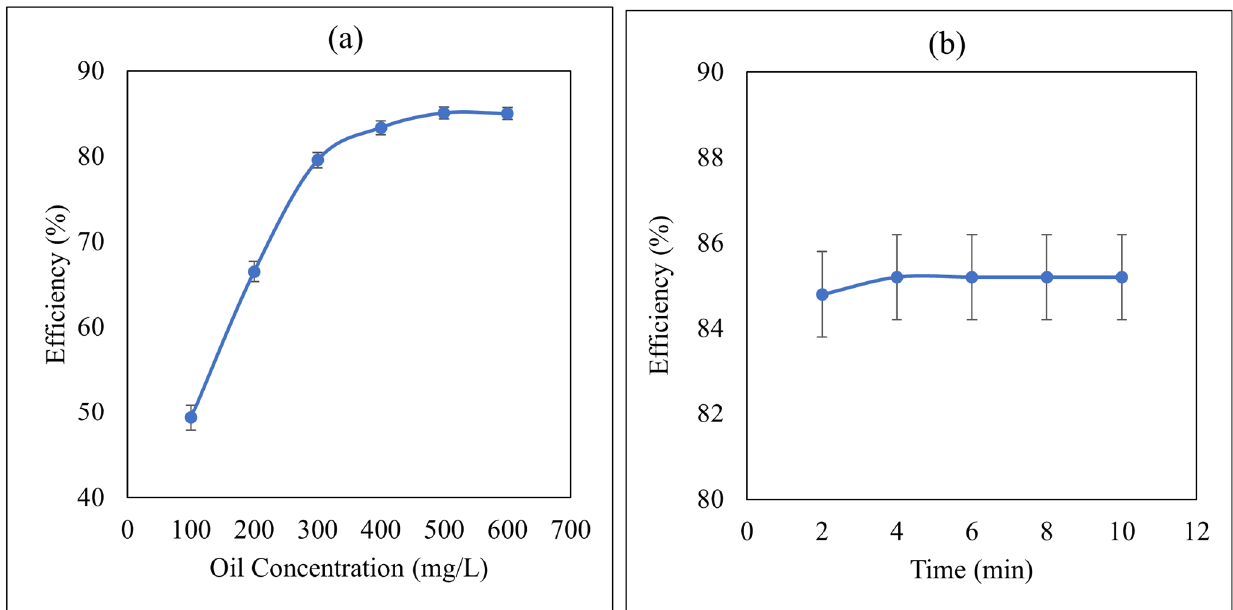
Figure 2. ( a ) Effect of the initial concentration of oil in PW on its removal efficiency by IL4 at Phase ratio (IL:PW) = 1:5, contact time = 5 min, and temperature = 25 °C, with σ = ±5.16 × 10 − 1 %, ( b ) Effect of the contact time on the removal efficiency of oil by IL4. Initial concentration of oil 500 mg/L, phase ratio (IL:PW) = 1:5, temperature = 25 °C, with σ = ±2.68 × 10 − 1 %.